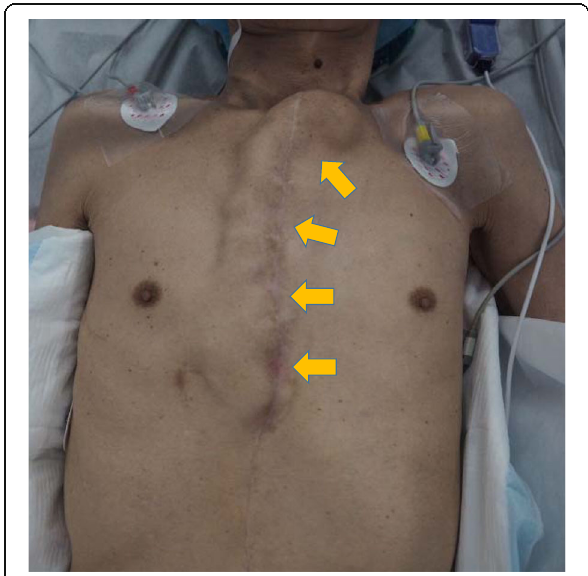
Fig. 1 Photograph of the patient taken just prior to surgery shows the significantly dilated pedicled jejunum through the antethoracic route